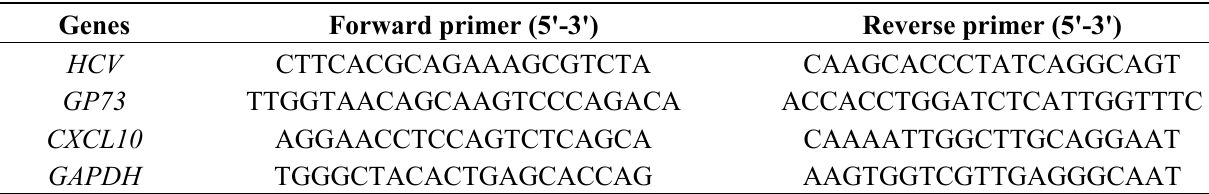
Table 2. Primer sequences for